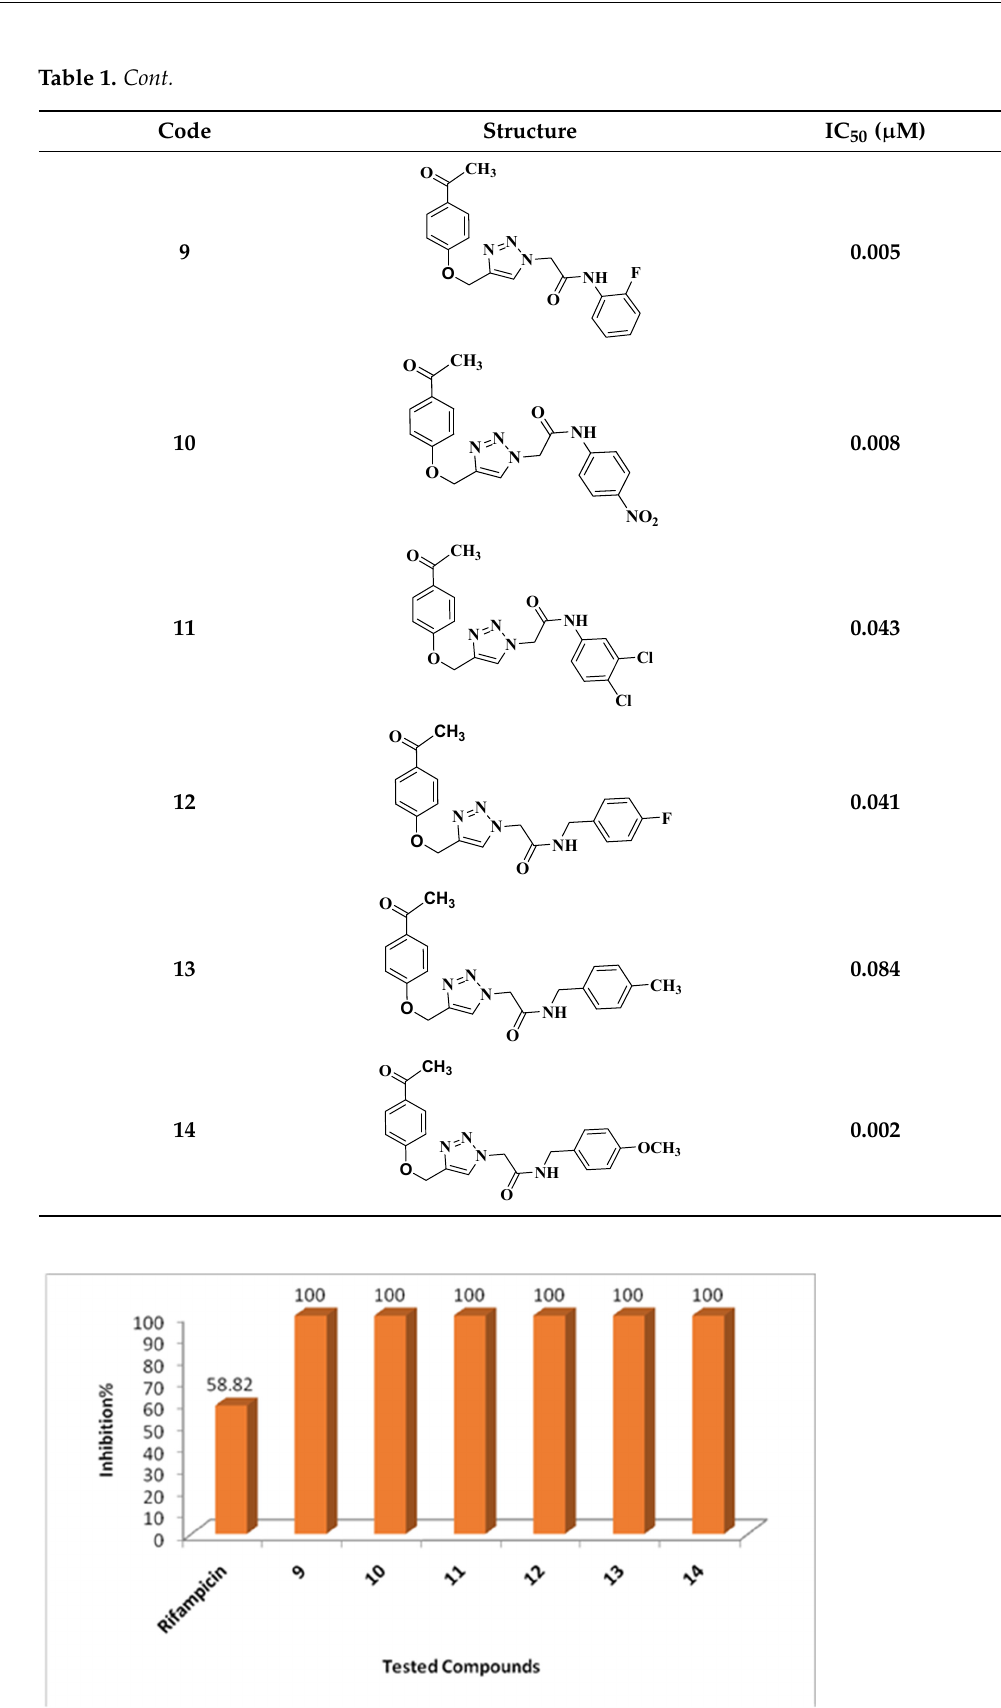
Figure 4. The inhibition percentage at 10